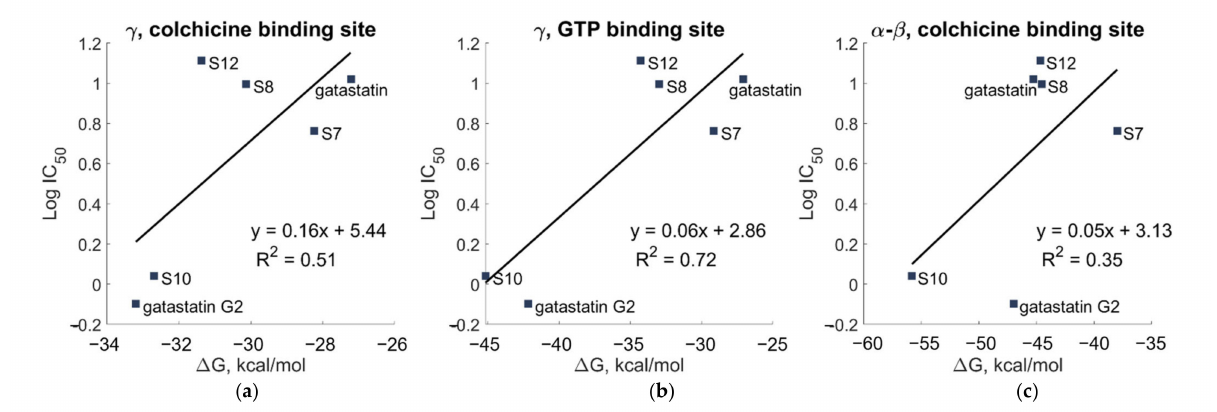
Figure 11. Scatterplot of experimental IC 50 values versus the binding free energy calculated by MM/GBSA ( a ) for the putative colchicine-binding site on γ , ( b ) for the GTP-binding site on γ , and ( c ) for the colchicine-binding site of α - β